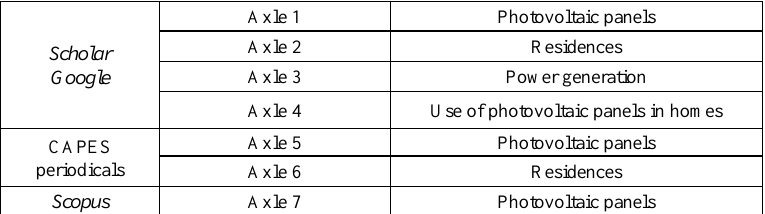
Table 1: Axes used for the